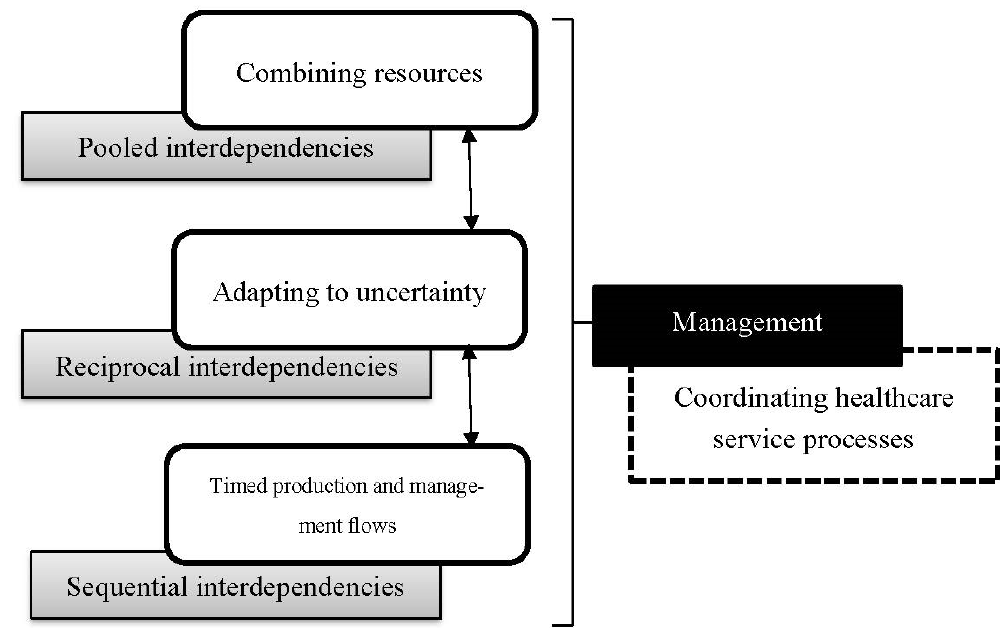
Figure 4. Interdependency and coordination of engineering processes. Adapted from Engelseth et al. [29]. In some cases, healthcare services may have strong sequential interdependency, and